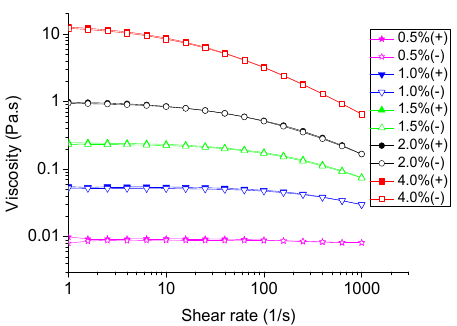
Figure 3. Apparent viscosity changes of TSP at different concentrations ( w / v ) at 25 °C with shear rates ranging from 1 to 1000 s − 1 (solid symbol) and from 1000 to 1 s − 1 (hollow symbol).